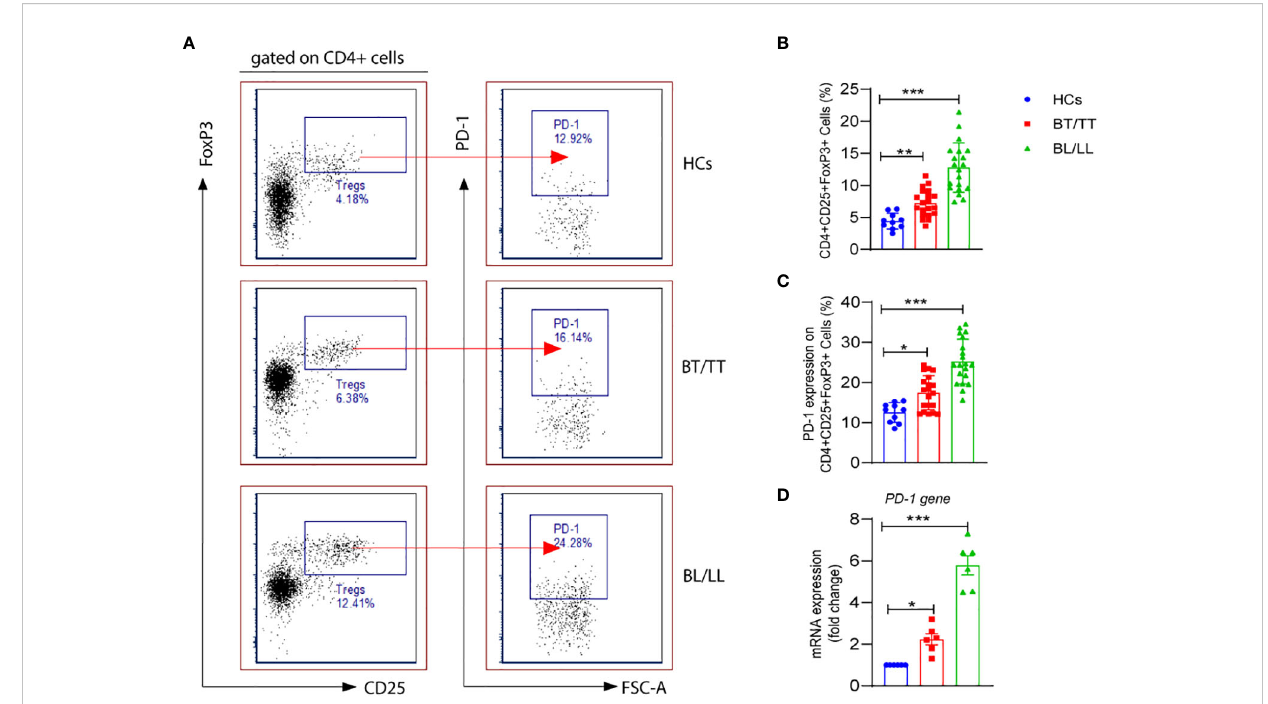
FIGURE 1 PD-1 expression on T regulatory cells in Leprosy (A) FACS plot showing the frequency of Treg (CD4+CD25+FoxP3) cells expressing programmed death 1 (PD-1) of one representative plot of each group is shown as determined by FACS analysis in healthy controls (n=10), tuberculoid patients (n=20) and lepromatous leprosy patients (n=20). (B) Scattered dot plots are showing expression of PD-1 on gated CD4+CD25+ FoxP3+ cells in different groups of Leprosy patients (BT/TT vs. BL/LL) and Healthy Contacts (n = 10) (C) Scattered dot plots are showing mRNA expression of PD-1 gene in isolated PBMCs from different groups of Leprosy patients (BT/TT vs. BL/LL, n=6) and Healthy Contacts (n = 6). Mean ± SD values are shown in each set while signi fi cance was determined by a P value of 0.05. A total of 100,000 cells were analyzed by fl ow cytometry. FCS express software was used for data analysis and Statistical analysis was done using one-way ANOVA for unpaired samples (*p < 0.05; **p < 0.005; ***p <